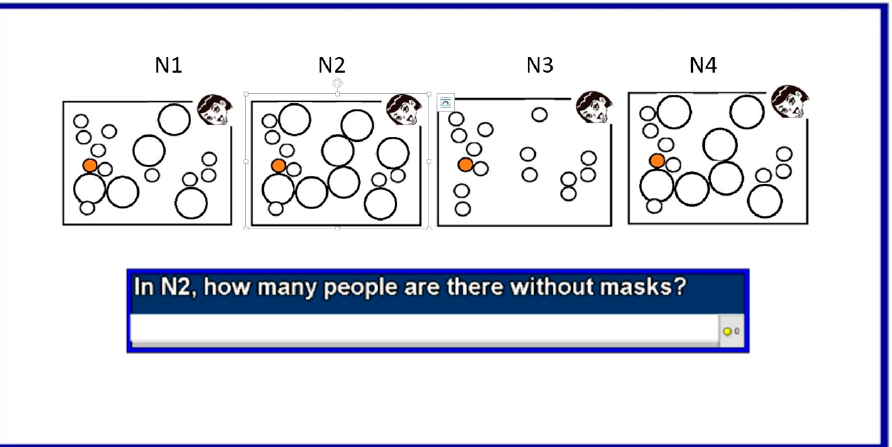
Figure 17. Example of a question that tested whether students understand the pool table model representing transmission across different days and are able to plot it.